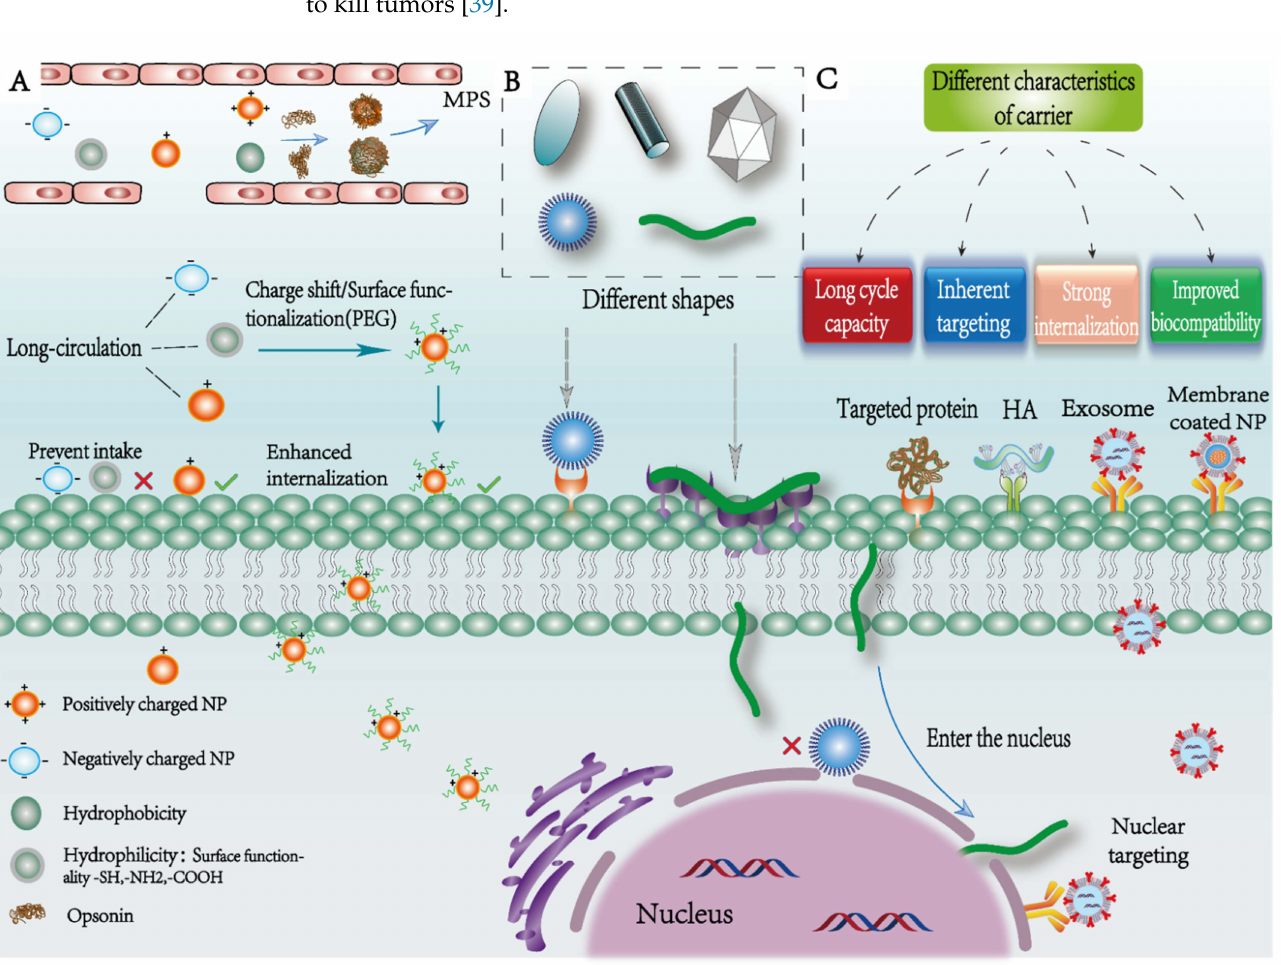
Figure 2. Effects of surface properties, shape and intrinsic properties on the targeting of NPs. ( A ) Transport of particles with different charge and surface chemical properties in vivo; ( B ) schematic diagram of cell uptake of NPs with different shapes; vermicular carriers find it easier to enter intracellularly by polyvalent contact with the membrane surface, and they even achieve nuclear targeting; ( C ) different intrinsic characteristics of the